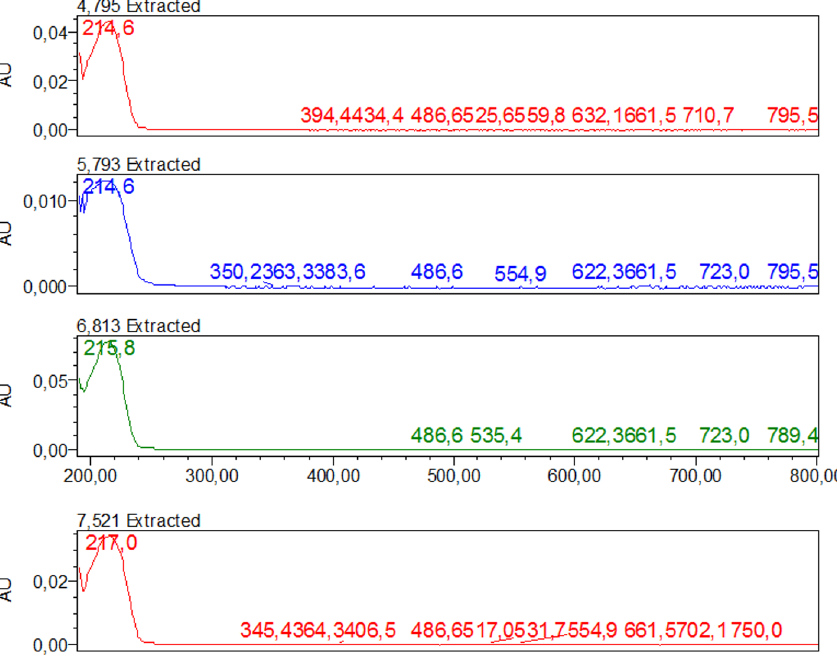
Fig 2. UV spectra from non-identified compounds from P . emarginatus oil suggesting presence of other vouacapan diterpenes.